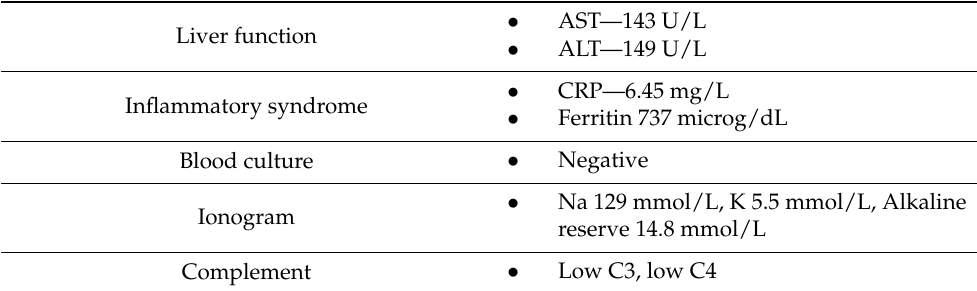
Table 1. Biological findings in a two-year-old male with